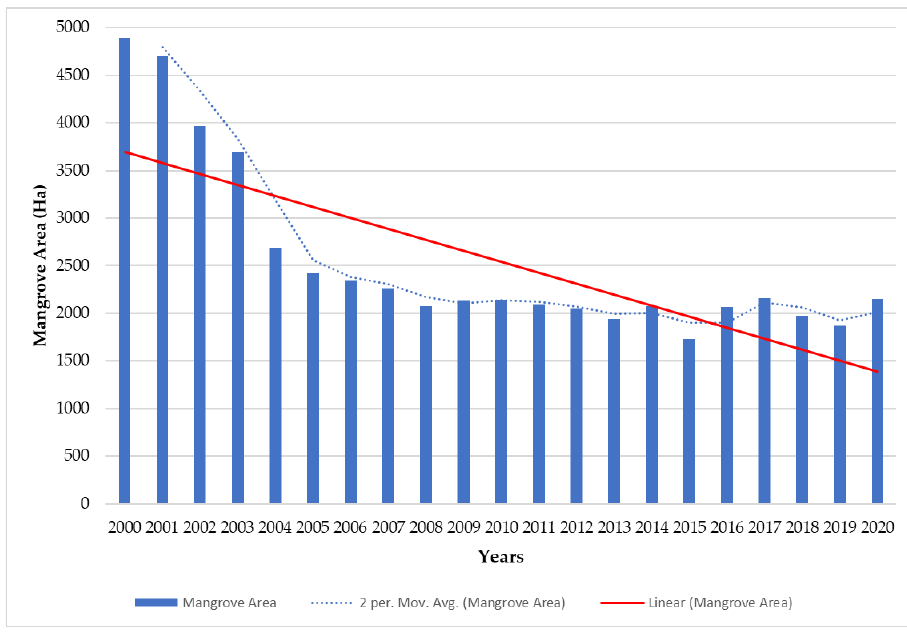
Figure 7. Mangrove area loss monitoring from 2000 to 2020 in East Luwu.